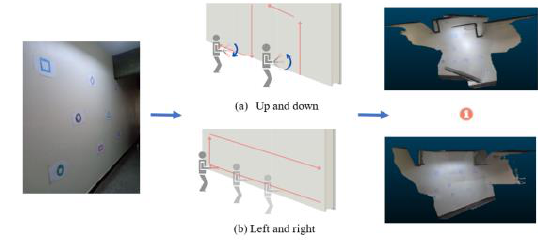
Figure 3. Acquisition result using the "up and down" (a) and "left and right" (b) approaches.